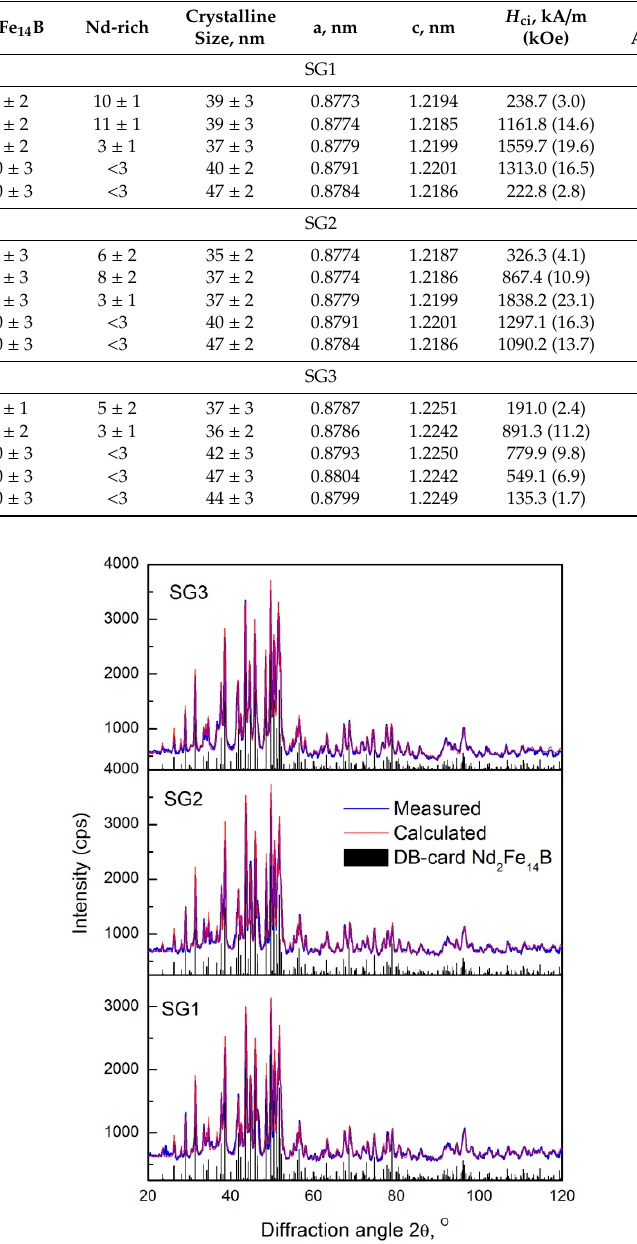
Figure 3. X-ray diffraction (XRD) patterns of samples after annealing. Figure 3. X-ray di ff raction (XRD) patterns of samples after Table 2. Results of the quantitative phase analysis and magnetic properties of the samples after annealing.